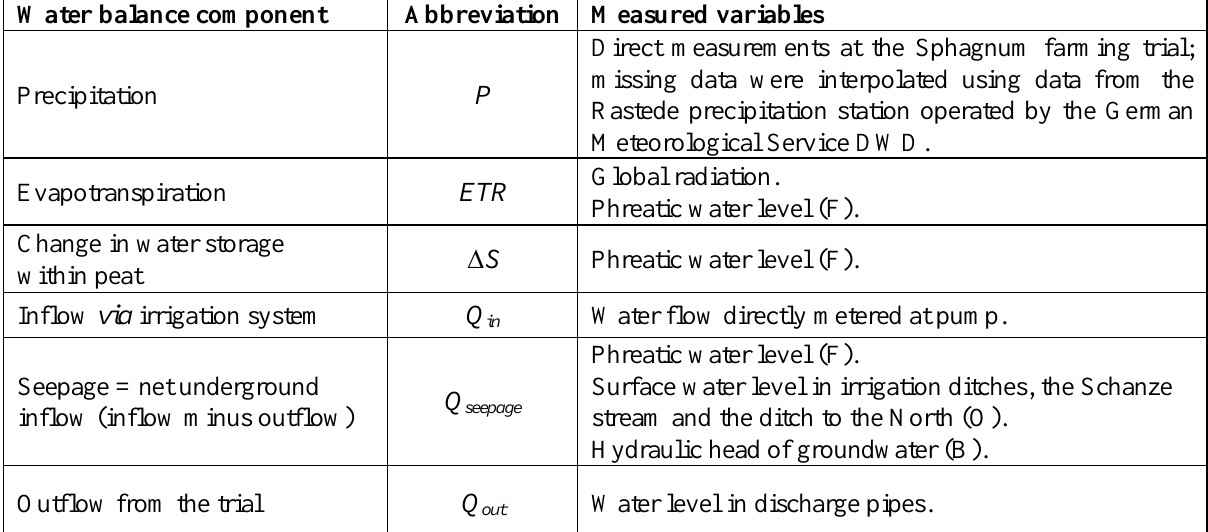
Table 1. Water balance components and measured variables of the Sphagnum farming trial ( cf . Figures 1, 3). Water balance component Abbreviation Measured